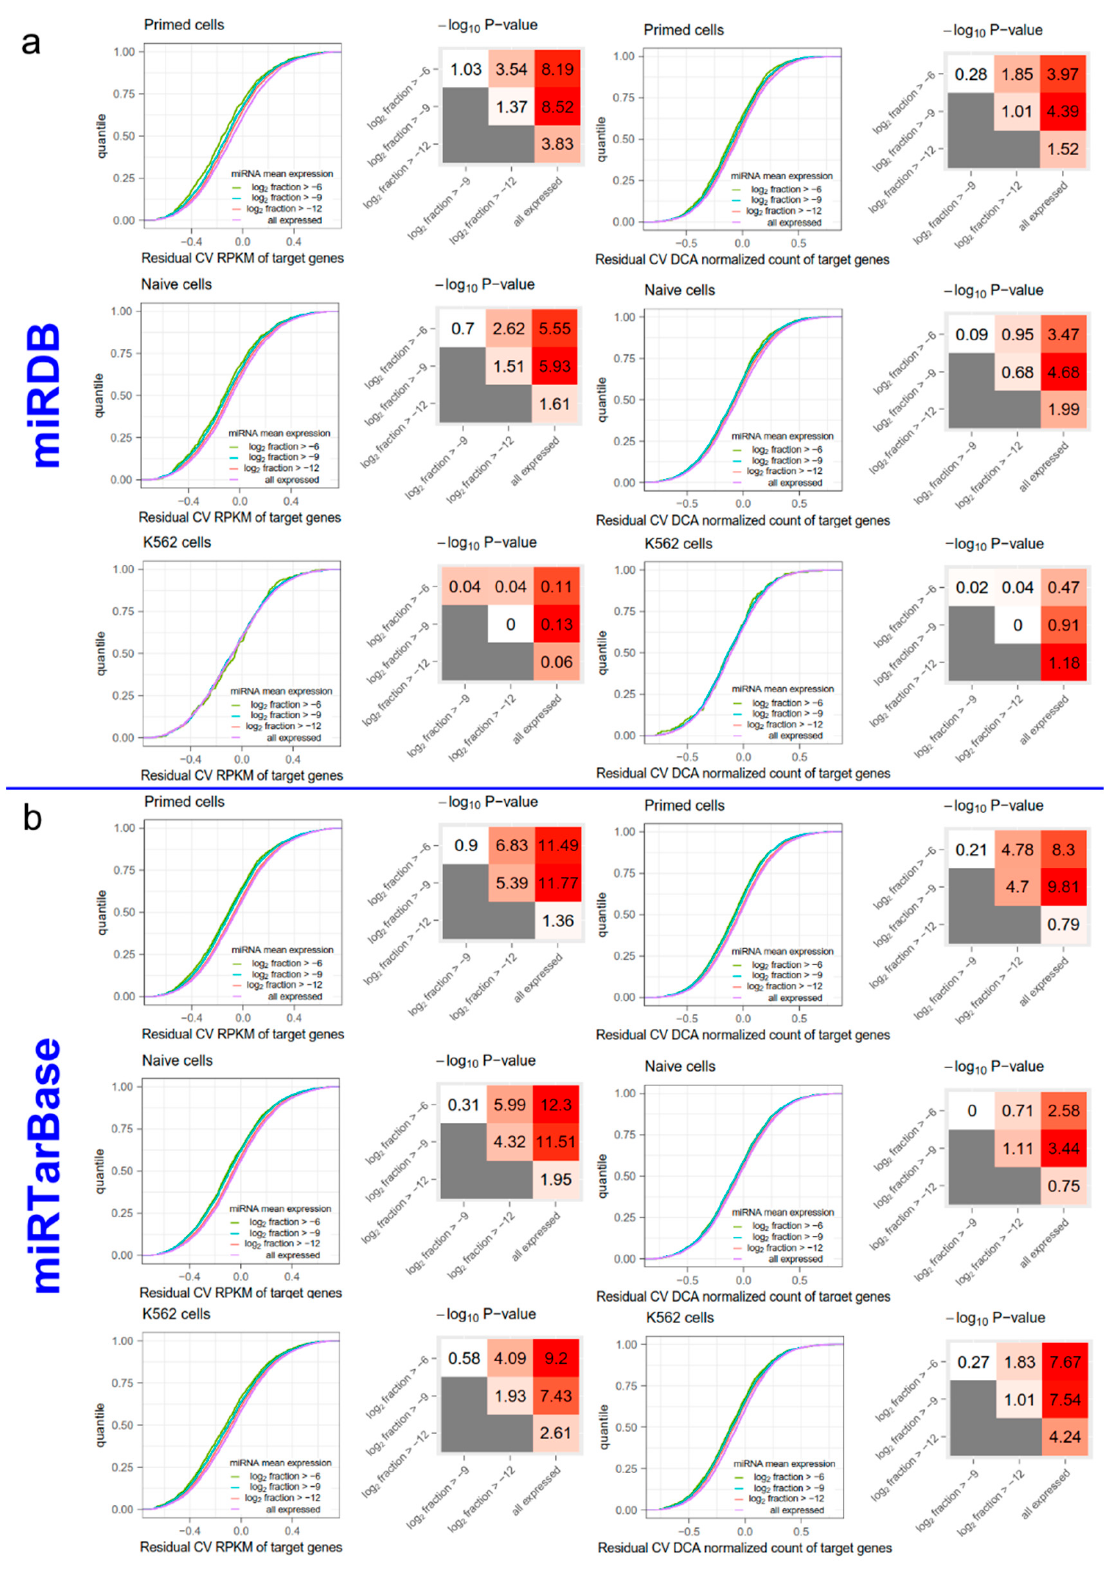
Figure A3. The evaluation of the noise-reduction effect of miRNAs using two distinct miRNA target prediction databases miRDB ( a ) and miRTarBase ( b ). The organization of this figure is the same as for Figure 1. Please refer to the legend of Figure 1 for details.